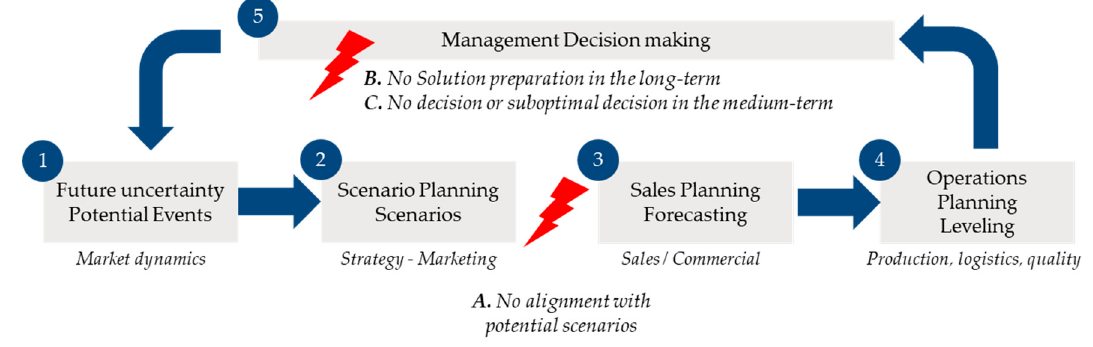
Figure 1. Managing future uncertainty (own elaboration).